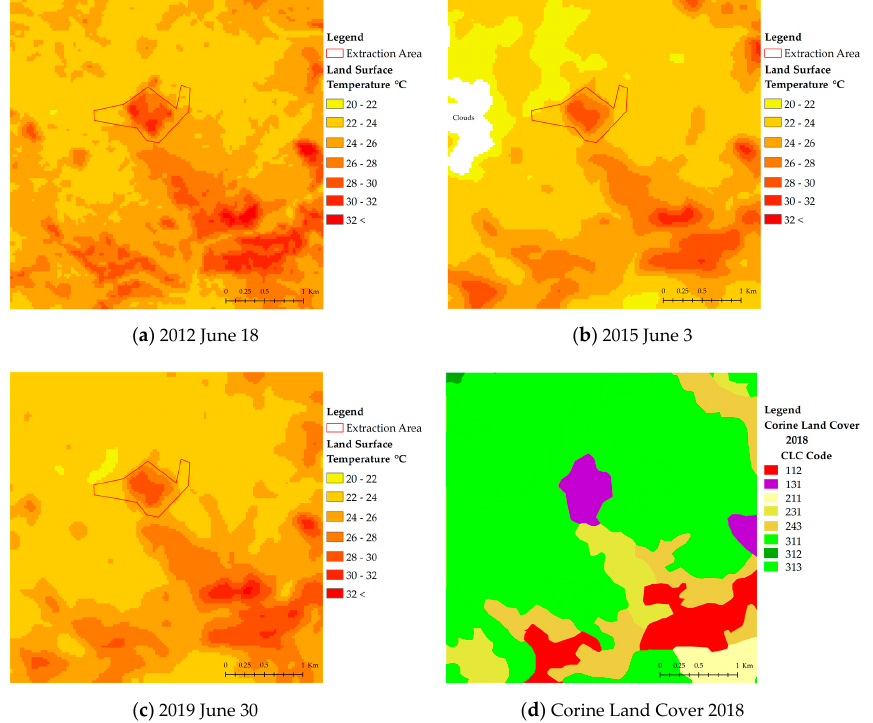
Figure 15. Land Surface Temperature of open-pit mine for years 2012 ( a ), 2015 ( b ), 2019 ( c ), and for Corine Land Cover ( d ). Corine Land Cover ( d